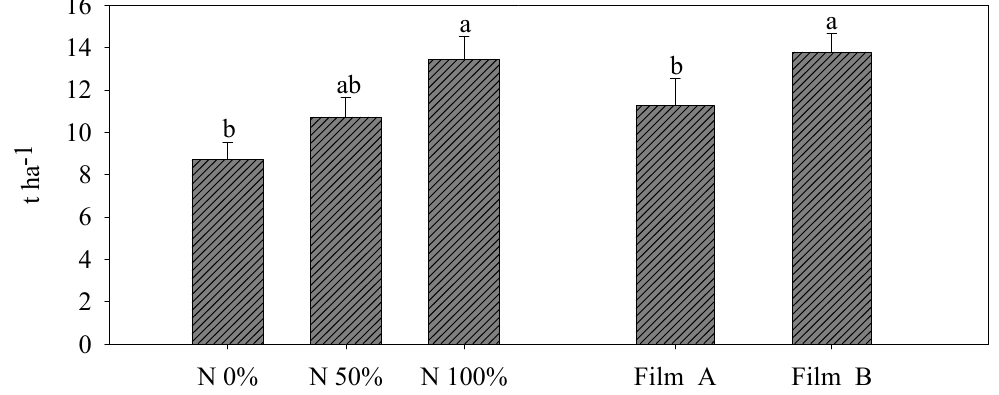
Figure 3. Effect of N fertilization (not fertilized = N0%; fertilized with 25 kg N ha − 1 = N50%; fertilized with 50 kg N ha − 1 = N100%) and plastic film (clear plastic film = Film A; light diffusion plastic film = Film B) on spinach yield (tons hectare − 1 : t ha − 1 ). Diverse letters on the bars indicate significant differences according to Duncan’s test ( p = 0.05). Vertical bars designate ± SE (standard error) of means.